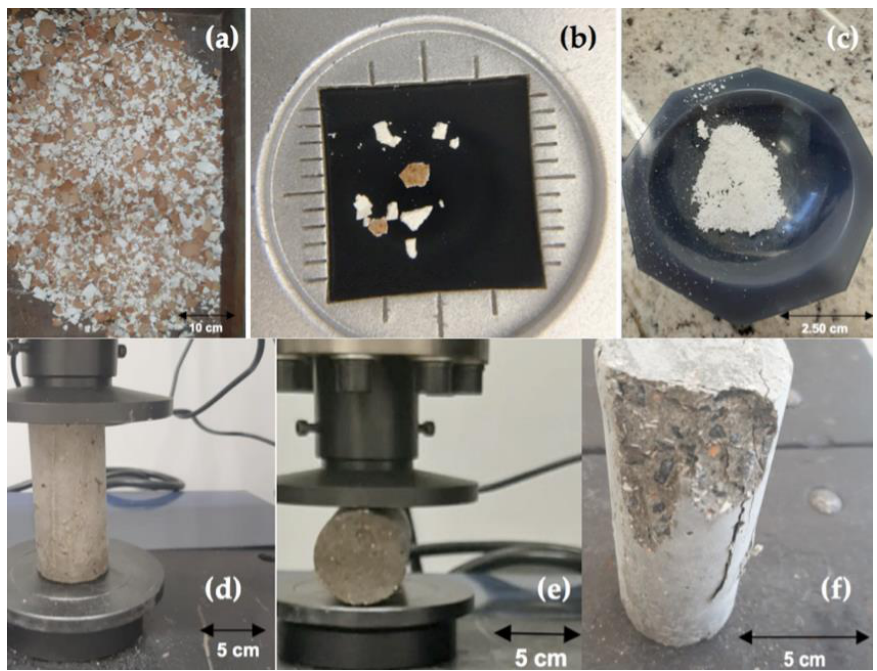
Figure 2. ( a ) The obtained eggshell (ES) portion, and ( b ) stereoscopic image showing the dimensions of coarser ES particles used to replaced with sand content, ( c ) finer ES particles inside agate mortar, ( d , e ) typical specimens subjected to compression and diametrical compression (indirect tensile behavior) and ( f ) typical fractured sample with sand content replaced with the coarse ES portion.